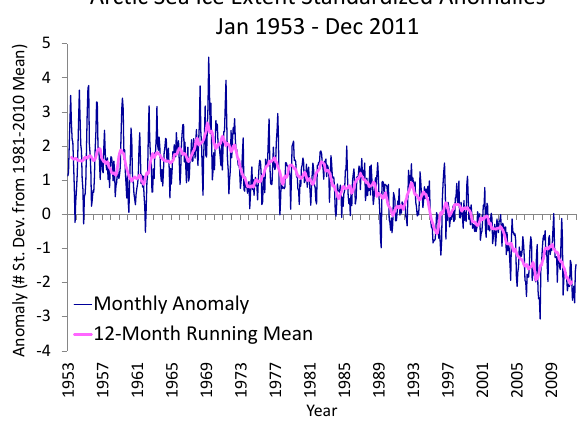
Fig. 4. The monthly standardized anomaly for January 1953 through December 2011, relative to 1981–2010 average period. Each value is the monthly anomaly normalized by the standard deviation for the month. Monthly values are in dark blue; a 12-month running mean is overlaid in